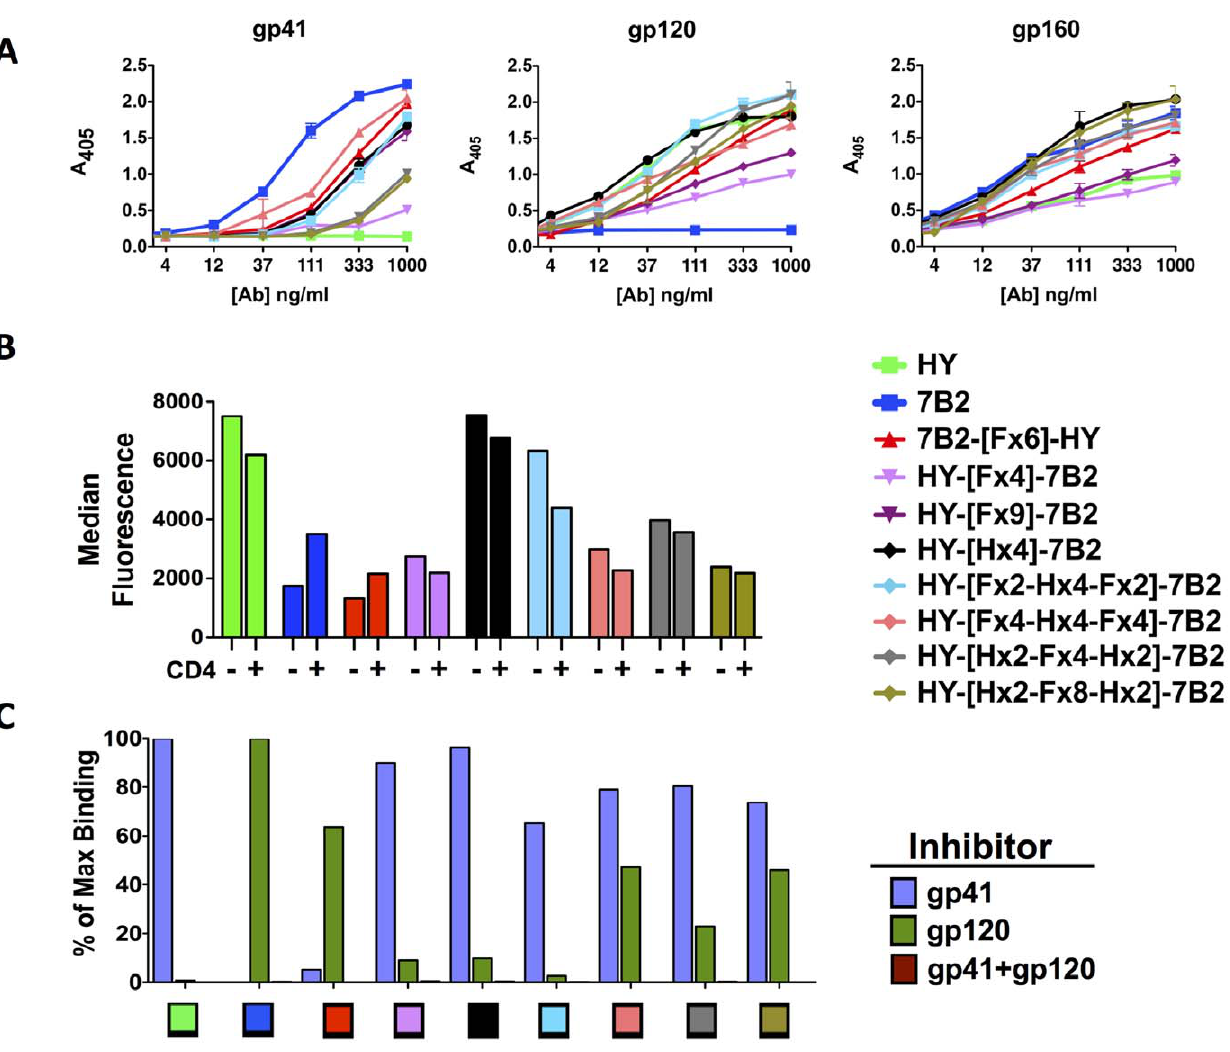
Figure 4. Effect of linker type on binding to Env. ELISA (A) and flow cytometry (B and C) were used to evaluate the binding of DVD-Igs with different linker types, linker lengths, and domain orientations to Env. Abs are identified by the same color in each panel. Methods are as in Figure 2. A. ELISA binding to protein/peptide Ag. B. Binding of Abs to persistently-infected H9/NL4-3 cells was detected by flow cytometry. Median fluorescence is reported for Abs tested at 10 m g/ml in the presence or absence of sCD4 (300 ng/ml) as noted along the x-axis. C. Inhibition of Ab binding to H9/ NL4-3 cells by soluble gp41 and gp120 Ags. Flow cytometry results are shown as percent of maximal binding (binding in absence of inhibitor). Ags were used at 10 m g/ml, Abs at 0.6 m g/ml. Binding in the presence of both Ags was less than 1%. ELISA and FACS studies are representative of at least 4 separate assays.